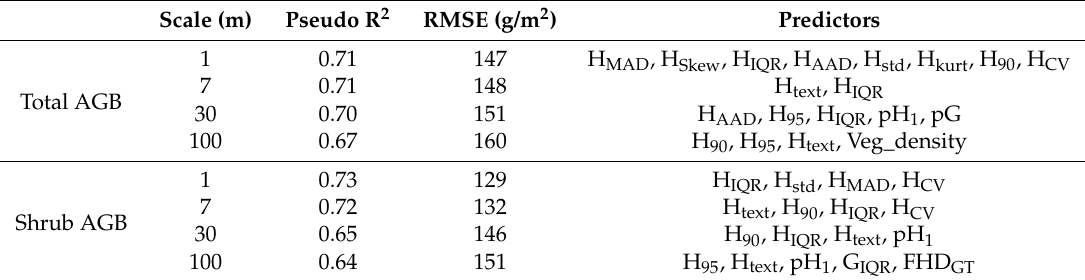
Table 4. Results of the RF regression using point cloud processing for total and shrub biomass at different resolutions representing 1-ha